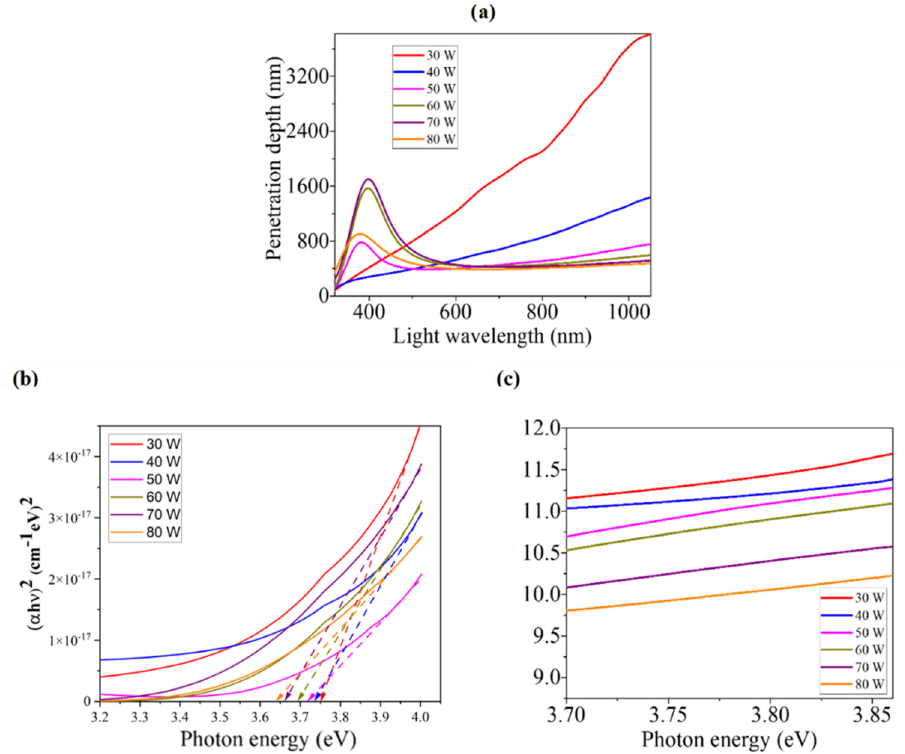
Figure 5. ( a ) Light wavelength dependence of penetration depth of as-grown films fabricated at different RF sputtering powers. Determination of: ( b ) energy bandgap using Tauc’s plot and ( c ) Urbach energy for different WOx films.